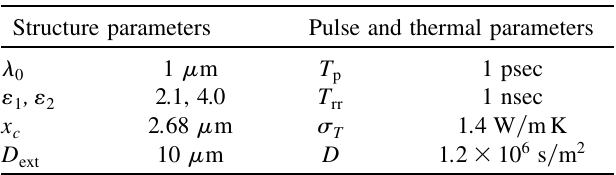
and the AV as a function of D , for a silica-zirconia AV int (cid:6) 0 : 2 (cid:3) m , (cid:1) T (cid:1) D (cid:6) FIG. 4. The relative change in temperature max j(cid:1) (cid:1) T (cid:3) int AV int (cid:1) D (cid:6) 0 : 2 (cid:3) m (cid:4) (cid:6) (cid:4) = (cid:1) T j as a function of the pulse separation T (cid:1) T AV int AV AV structure parameters excluding T